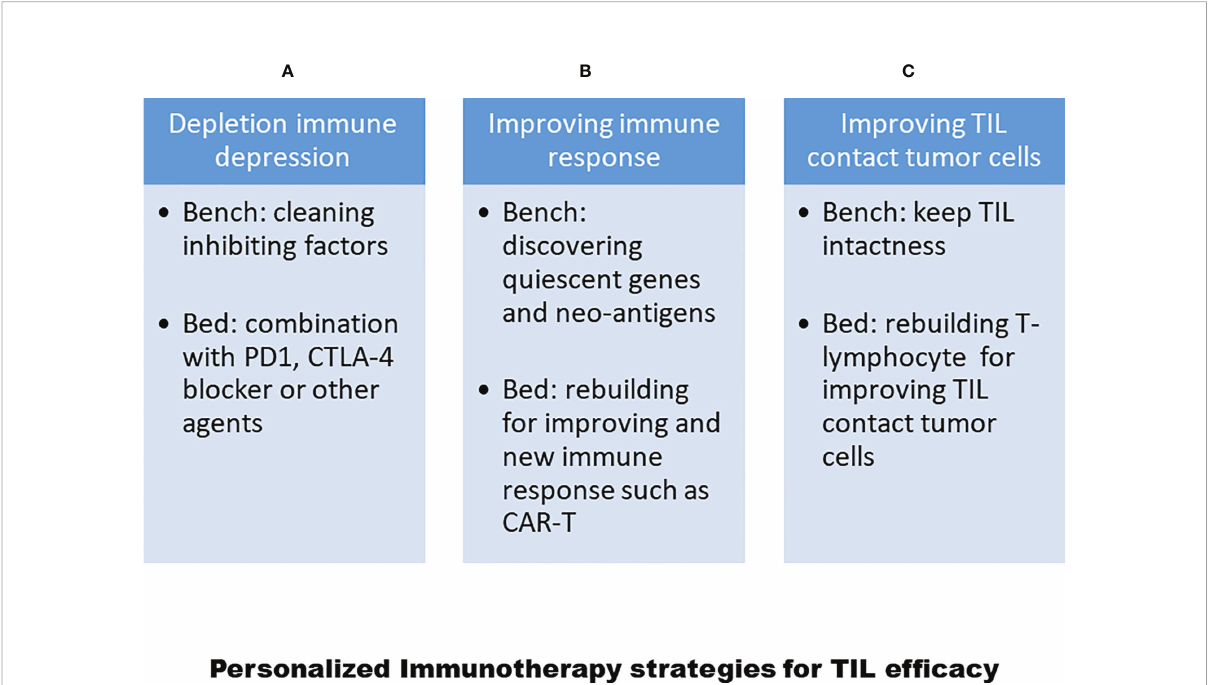
FIGURE 3 Strategies for personalized TIL therapy to increase TIL ef fi cacy. (A) Depleting immune-depression regimen including clean immune depression in experiments and add PD1 or CTLA4 blocker. (B) Improving TIL immune response in experiments such as discover quiescent genes for TIL and neo-antigens from tumor cells, and rebuilding immune responses for TILs or setting up Car-T or TCT-T cells. (C) Maintaining T-cell intactness and improving T-cell homing into tumor sites.